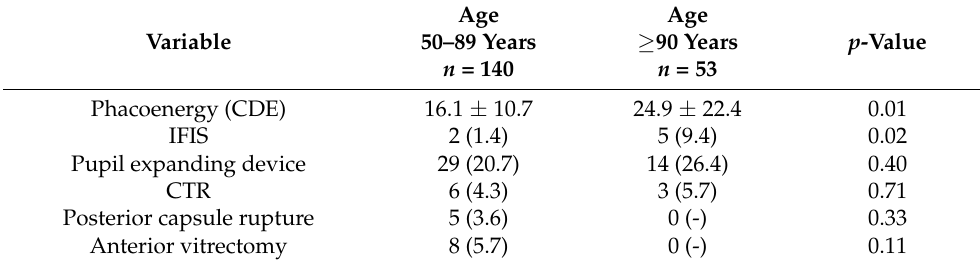
Table 2. Intraoperative procedures and complications in study